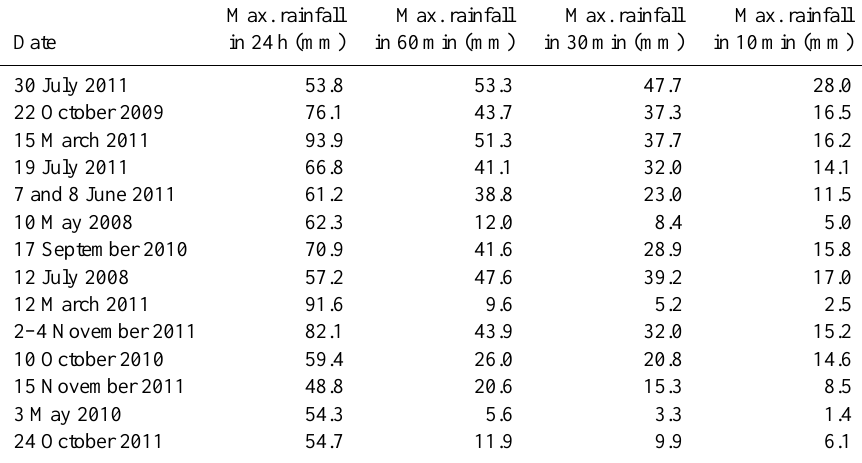
Table 3. Maximum rainfall in 24h, 60, 30 and 10min for each event.